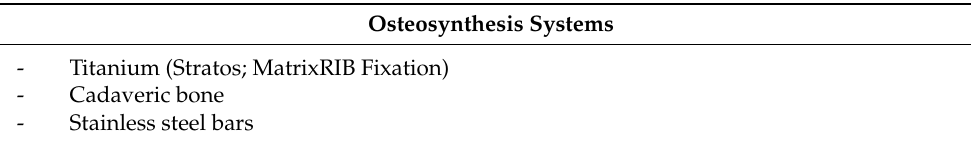
Table 5. Osteosynthesis systems for the